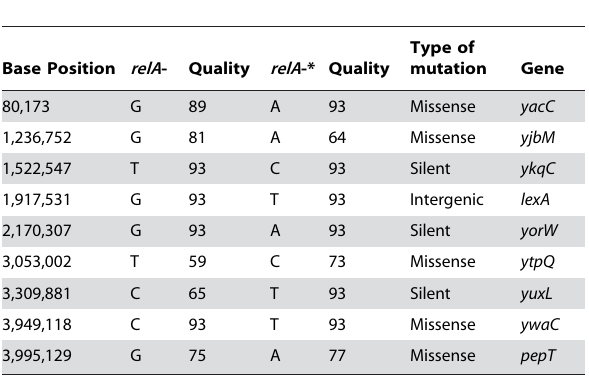
Table 3. Nucleotide differences between relA - and the relA -* suppressor strain.